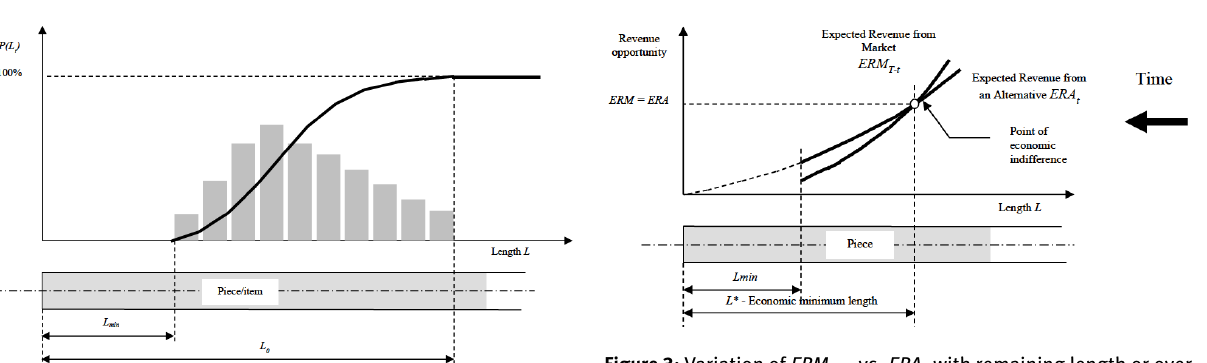
T − t vs. ERA t with remaining length or over